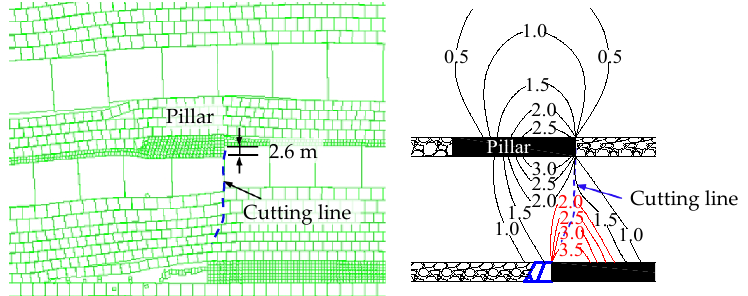
Figure 20. Interburden and coal pillar vertical cutting occurred by the working face strong weighing.